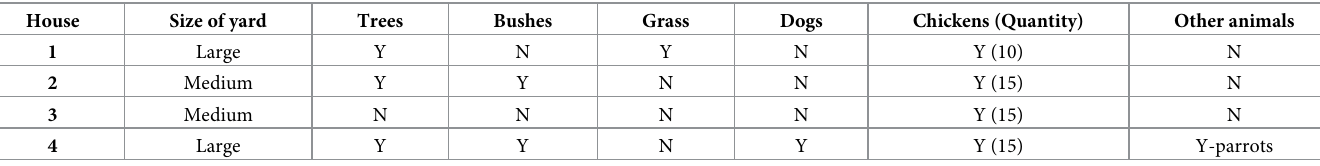
Table 1. Additional characteristics of the